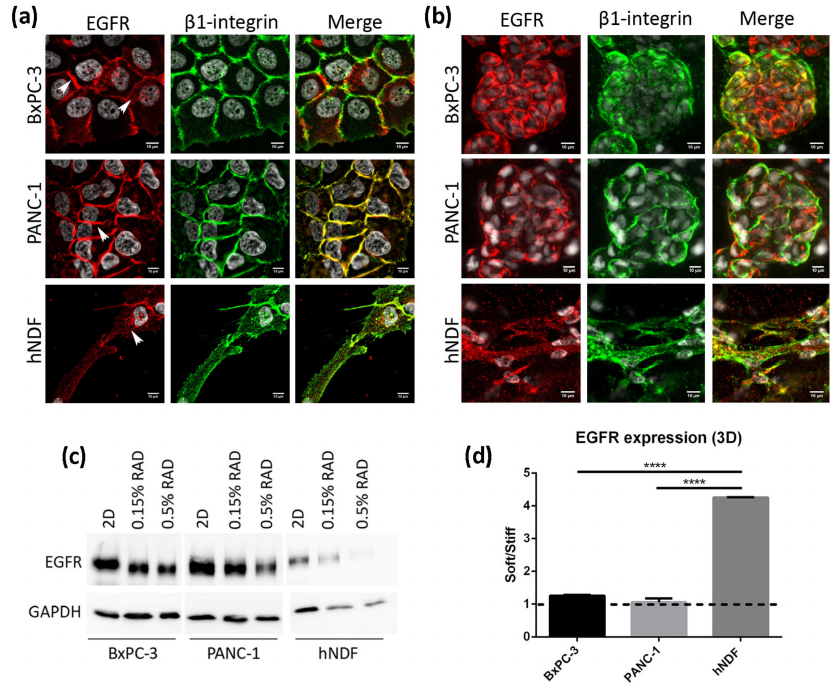
Figure 2. EGFR expression in 2D and 3D cultures. ( a ) EGFR (red) and β 1-integrin (green) immunofluorescence counter- stained with DAPI (grey) in BxPC-3, PANC-1 and hNDF cells cultured in 2D monolayer and ( b ) Z-projection of EGFR and β 1-integrin immunofluorescence in BxPC-3, PANC-1 and hNDF cells in 3D RAD16-I scaffold at 0.15% peptide concentration. Scale bars represent 10 µ m; ( c ) Western blot bands of EGFR in 2D and 3D cultures; ( d ) quantification of EGFR in 3D cultures represented as the ratio between soft and stiff cultures. GAPDH was used as loading control. One representative blot is shown. Experiments were repeated three times (N = 3), and statistical differences are indicated as **** for p < 0.0001.